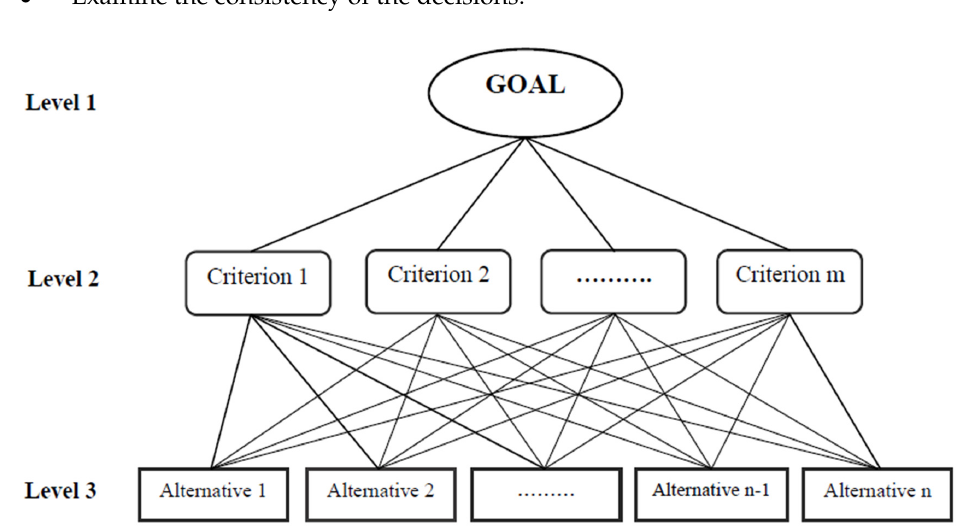
Figure 6. Hierarchical structure of the problem.